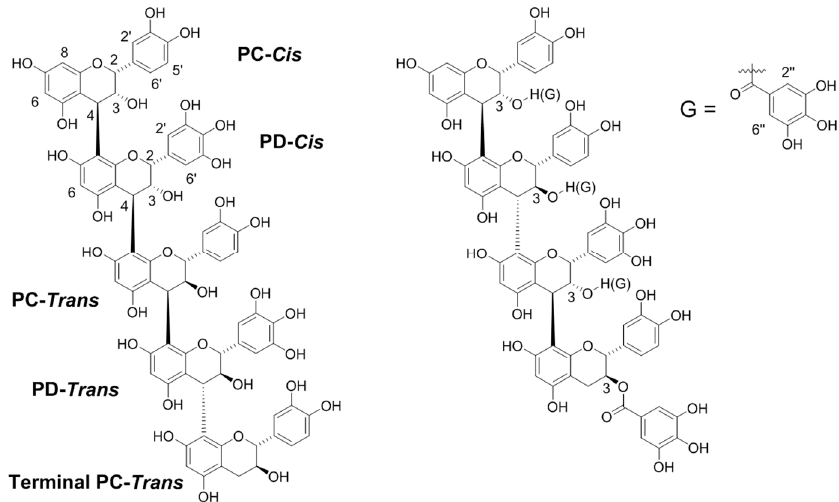
Figure 1. Common representation of condensed tannin structures. Left structure: PC = procyanidin; catechin ( trans isomer) or epicatechin ( cis isomer). PD = Prodelphinidin; gallocatechin ( trans isomer) or epigallocatechin ( cis isomer). In addition, hydroxyl groups, particularly on the C-3 hydroxyl, may be esterified with a galloyl (G) group (structure on the right). Carbons 2, 3, and 4 of the C ring, 2 ′ and 6 ′ of the B ring, 6 and 8 of the A ring, and 2” and 6” of the D ring are labeled.